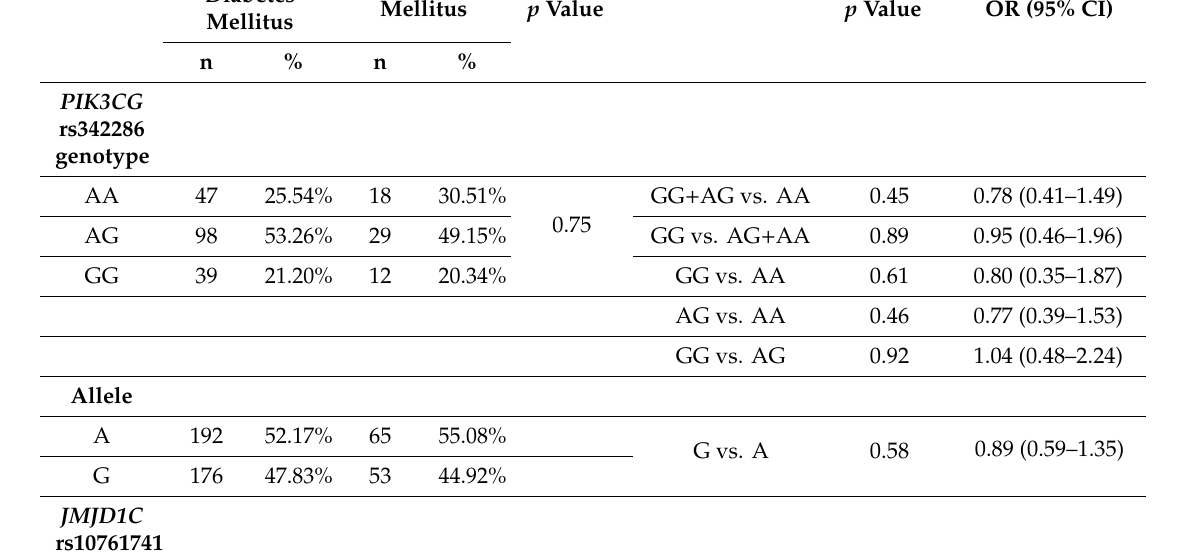
Table 10. Distributions of the PIK3CG , JMJD1C , and SHH genotypes and alleles in unstable angina patients with and without diabetes mellitus (DM). Without Diabetes Mellitus